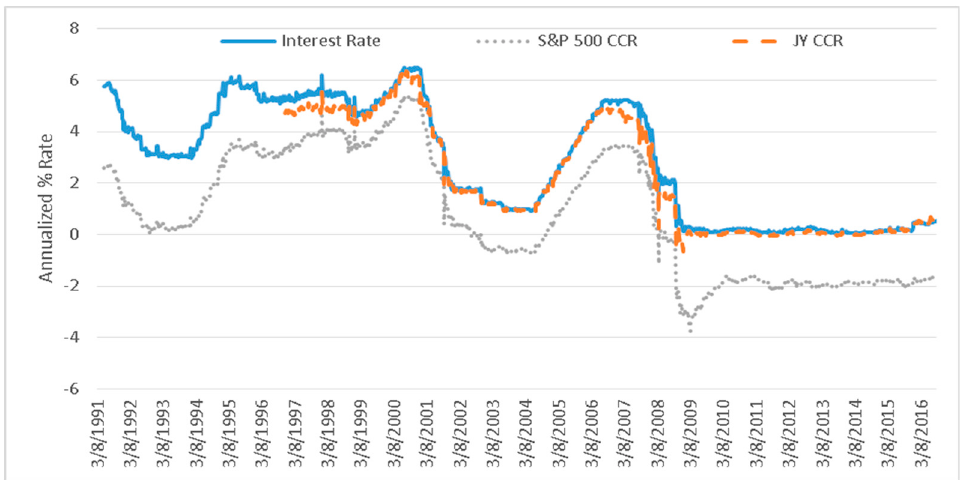
Figure 1. (US $ denominated) Interest Rate and Spot Asset Carry Cost Rates.